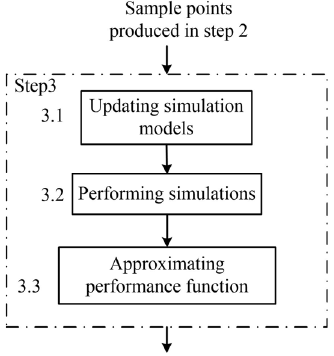
Figure 2. Detailed operation of step 3.